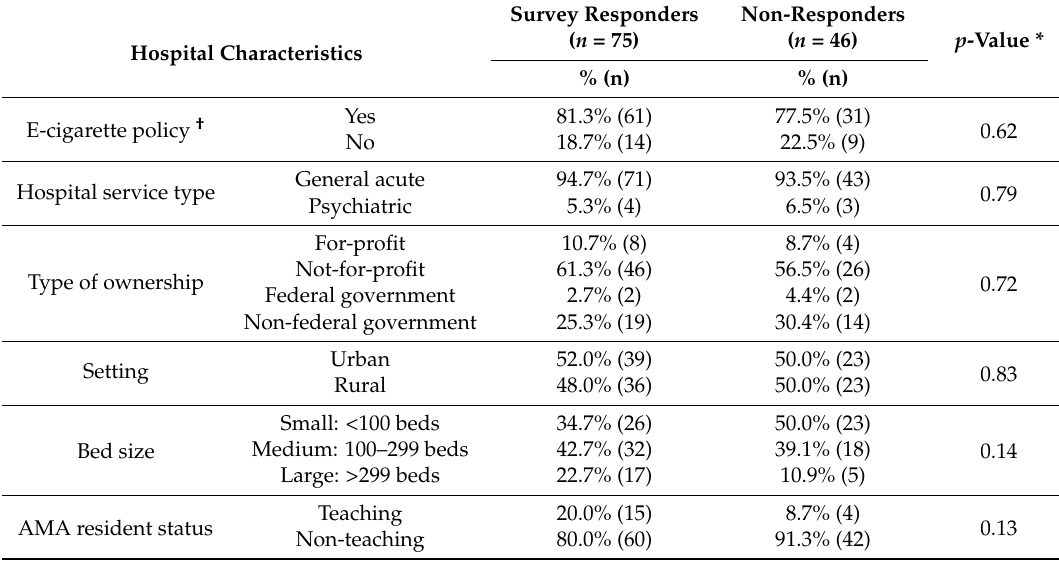
Table 1. E-cigarette policies and demographics of NC